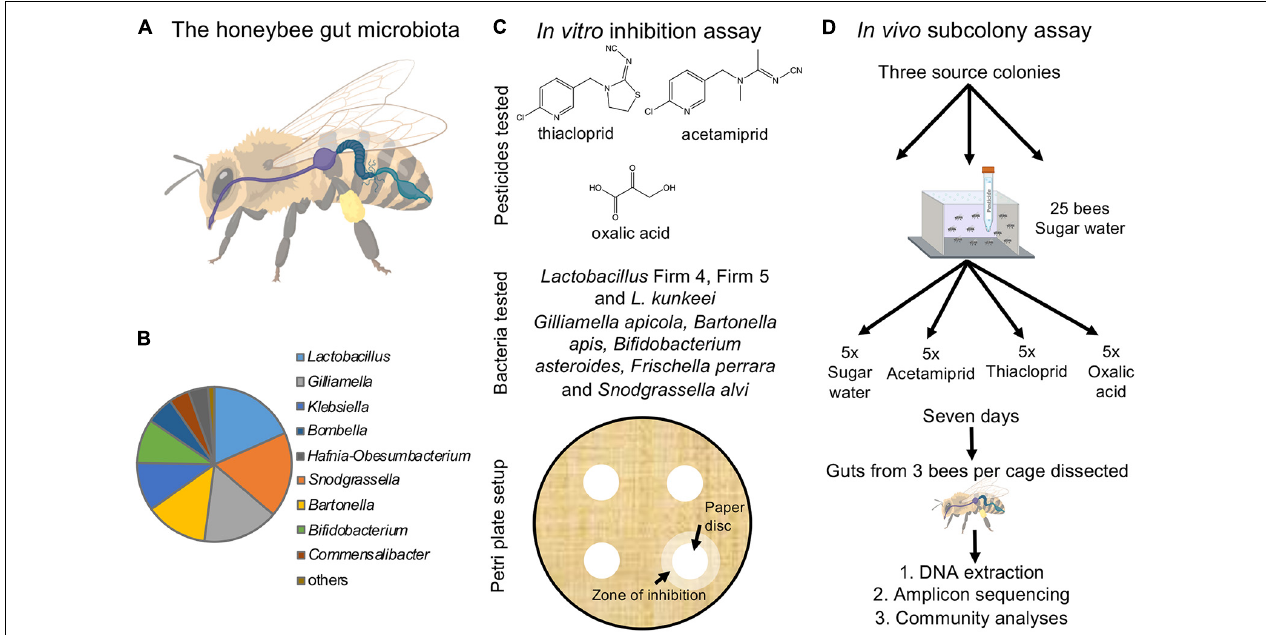
FIGURE 1 | The honeybee gut microbiota and experimental setup. (A) The honeybee gut is compartmentalized and includes the crop (purple), midgut (dark blue), and hindgut (soft blue), which is further divided into the ileum and rectum (created and reproduced with permission from Biorender.com). (B) The relative abundance of core microbial genera in the honeybee gut microbiota (based on our dataset). (C) Overview of the in vitro experiment. Lawns of eight core bacteria were used to test the effects of three pesticides inoculated on 1 cm filter paper discs (structures drawn in ChemDraw). Inhibition was scored as the presence/absence of a distinct zone of inhibition forming around the disc. (D) Schematic of the in vivo experiment. For each of the three colonies, 20 sub-colonies were established each with 25 bees exposed to either of the three pesticides dissolved in sugar water or sugar water alone (control). After 7 days of exposure, three bees per sub-colony were randomly picked, their guts dissected and extracted, and the community composition established using amplicon